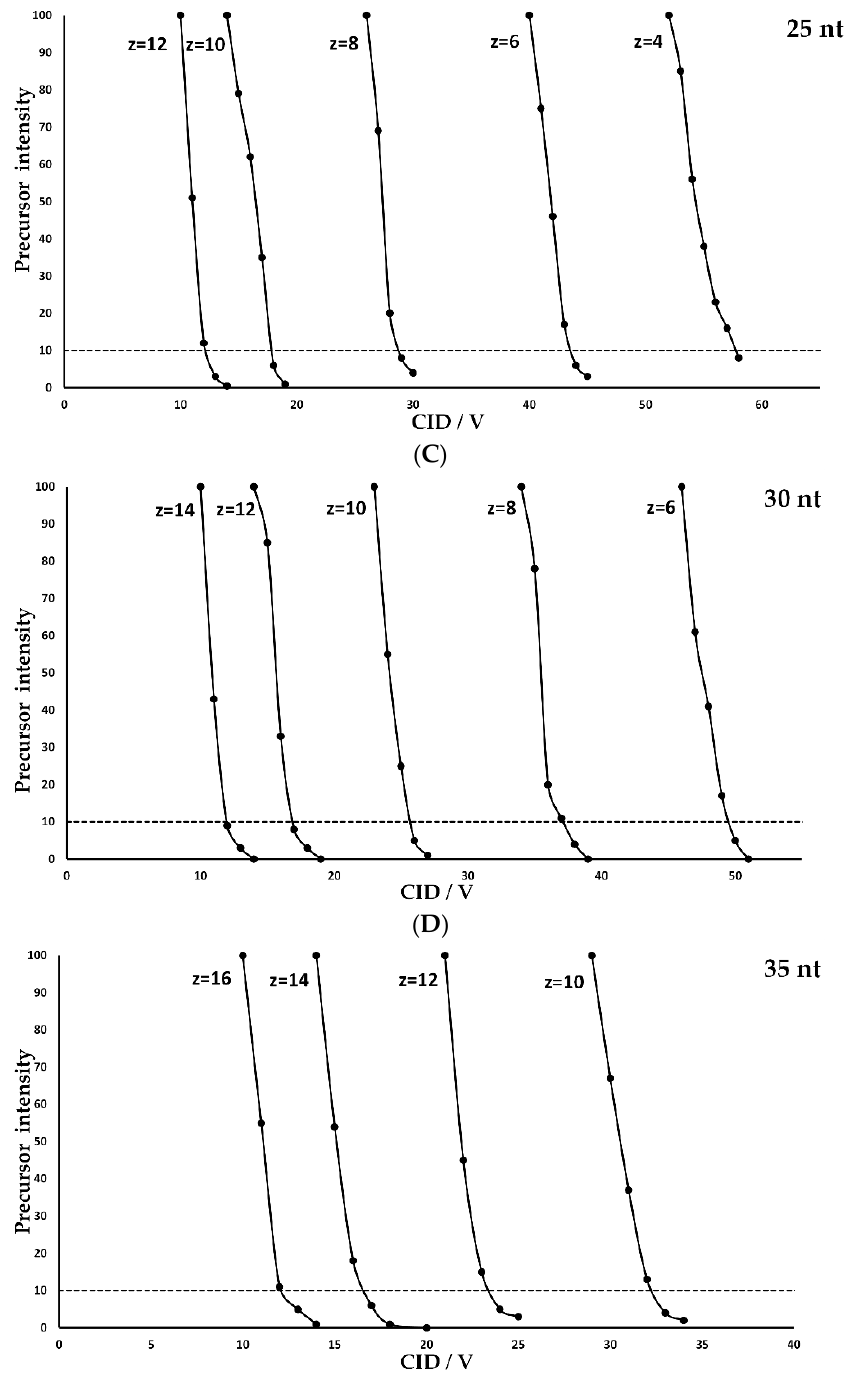
Figure 1. Precursor intensity at different CID fragmentation voltages in relation to charge states of poly(dT) 15 nt in ( A ), 20 nt in ( B ), 25 nt in ( C ), 30 nt in ( D ) and the 35 nt poly(T) in ( E ).